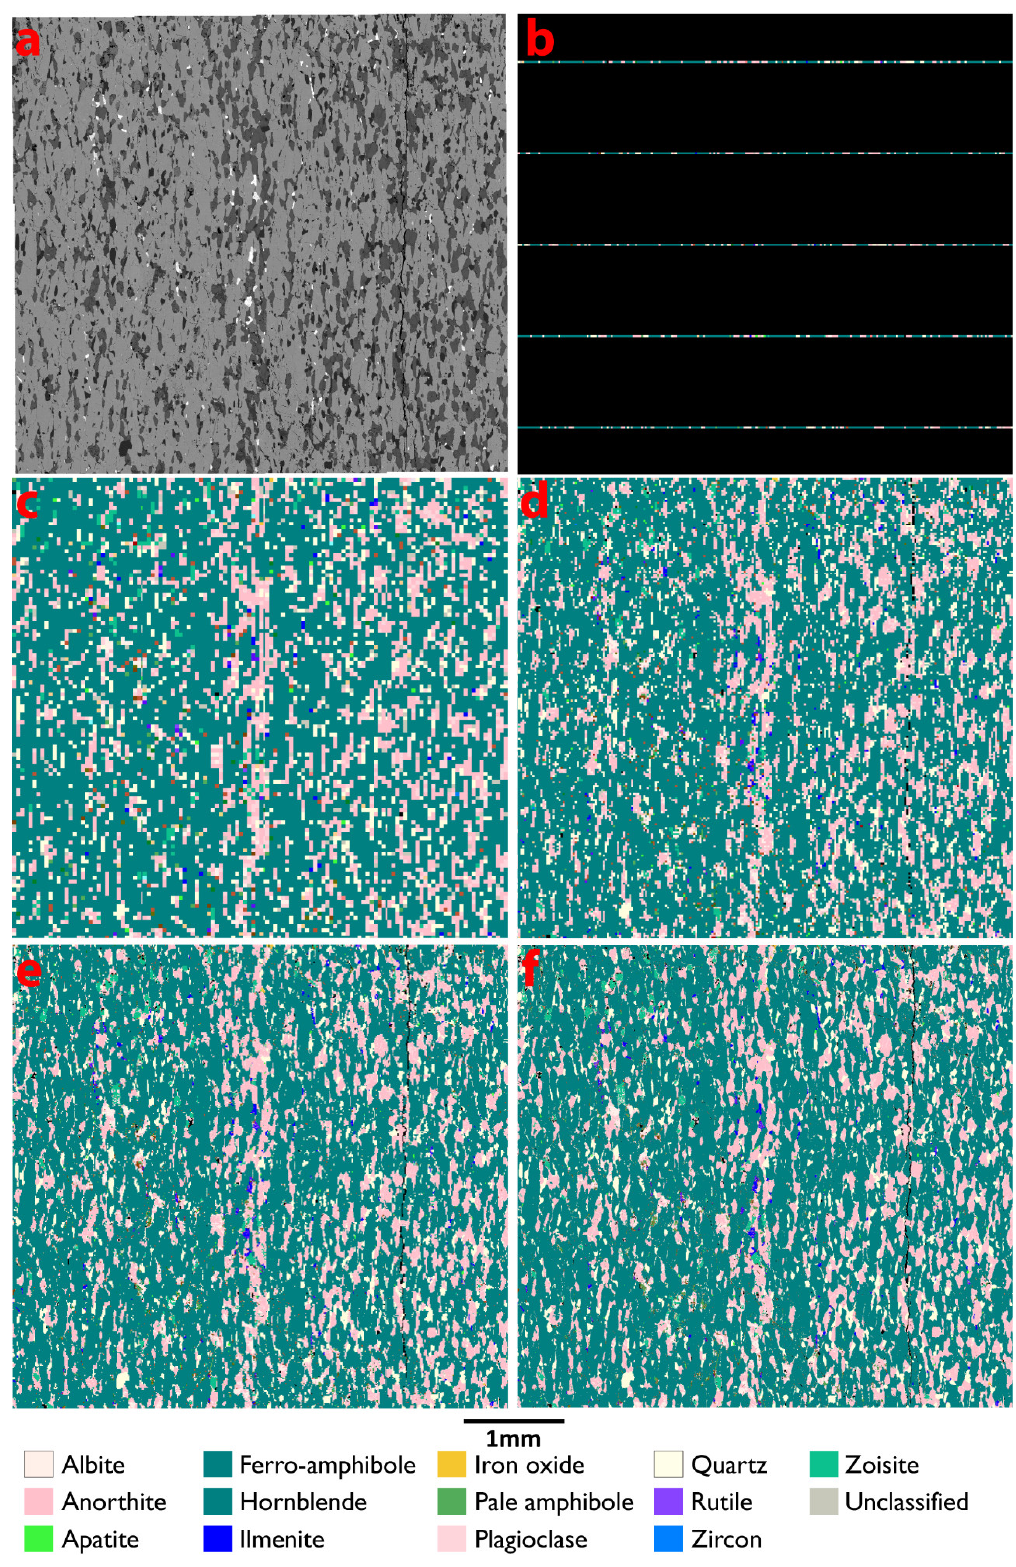
Figure 2. Same area of sample 511923 analyzed with different methods. ( a ) BSE image. ( b ) 20 µm step size line-scan. ( c ) 40 µm step size mapping. ( d ) 20 µm step size mapping. ( e ) 10 µm step size mapping. ( f ) 5 µm step size mapping. For analysis times see Table 3. The 10 µm step size map consists of 244606 analysed pixels.